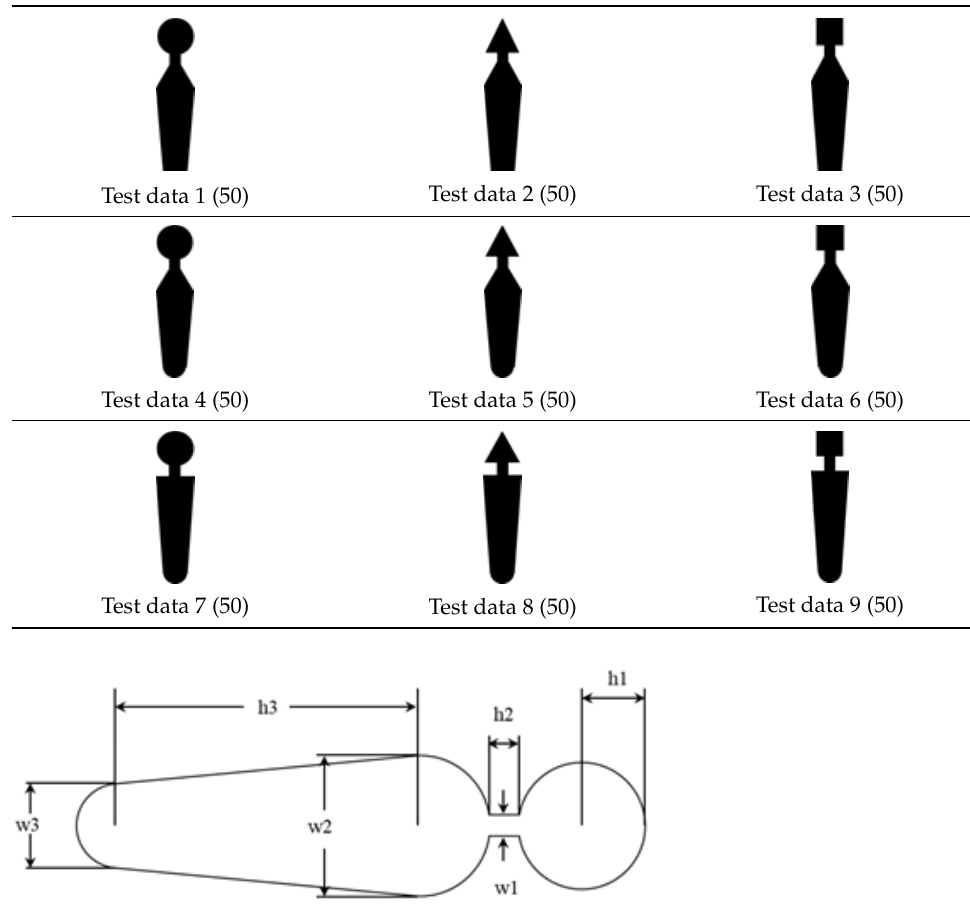
Table 5. Definition of the objective function and design variables.